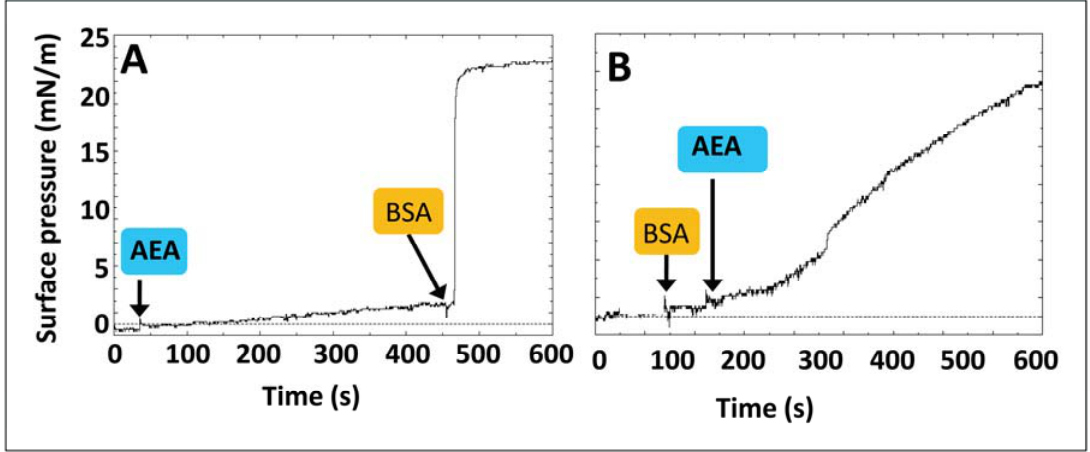
Figure 4. Protein-assisted dissolution of AEA. Low amounts of AEA (in the nanomolar range) do not contain sufficient amounts of AEA to trigger and thus do not significantly increase the surface pressure ( A ). The addition of lipid-free bovine serum albumin (BSA) induces the immediate dissolution of AEA aggregates (surface pressure increase). Bovine serum albumin by itself has no effect on the surface pressure ( B ). Under these conditions, the addition of AEA (the same concentration as in panel A) resulted in a sudden increase in surface pressure, indicating that BSA immediately dissolved AEA. The effects of BSA on AEA solubility were discussed in Chapter 5 of reference [9].